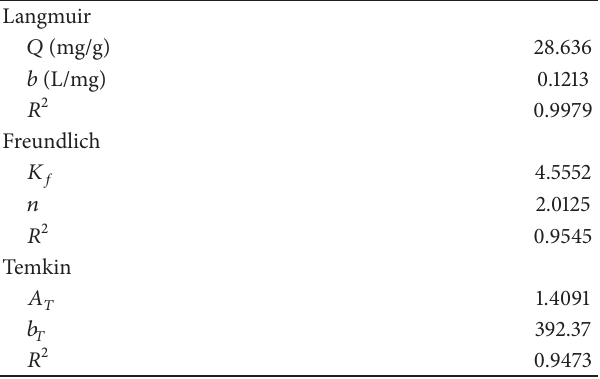
Figure 9: Temkin biosorption isotherm for lead at 0.1g in 30mL of biosorbent concentration and solution pH of 6.0. Table 3: Langmuir, Freundlich, and Temkin isotherm constants and correlation coefficients.